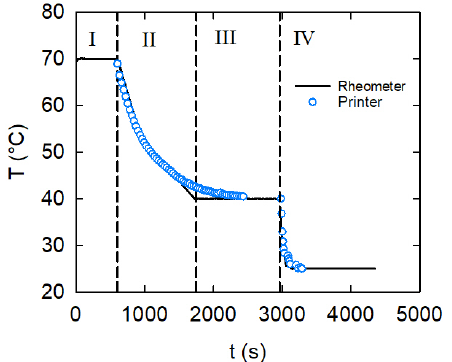
Figure 6. The thermal history applied to the kC ink in the rheometer simulation of the printing process. The extrusion temperature was 40 °C. The four temperature regions are discussed in the text. The measured printer temperatures, already reported in Figure 2, are added here for compari- son.